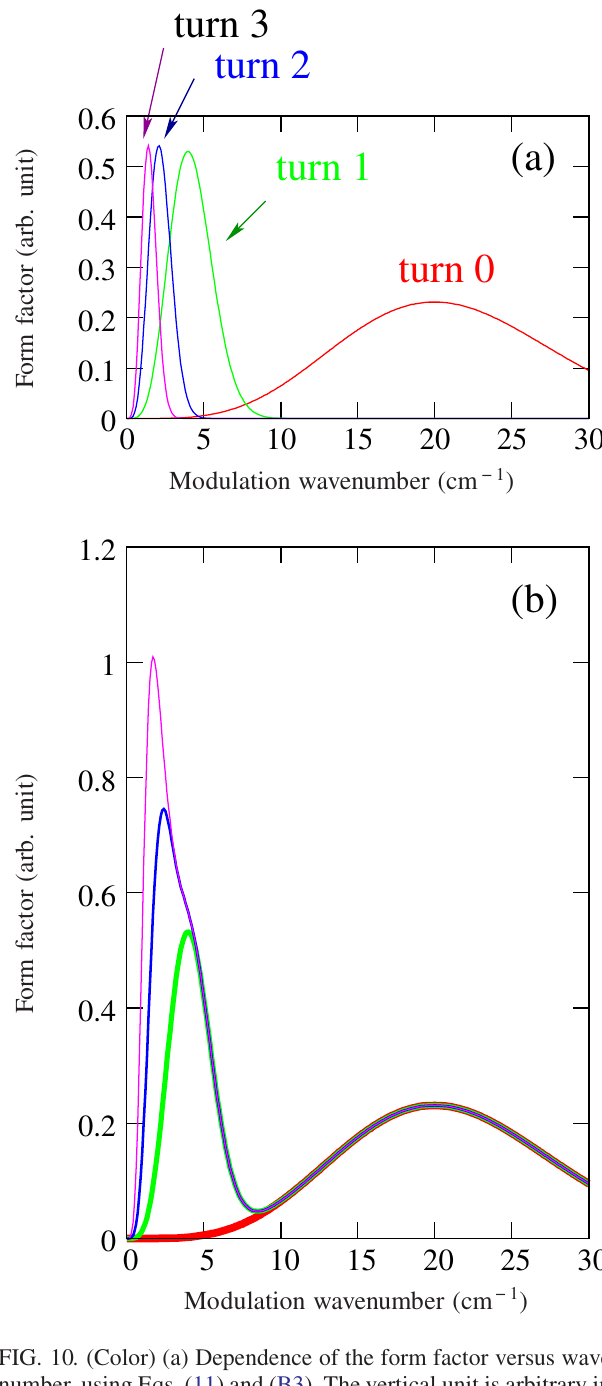
FIG. 10. (Color) (a) Dependence of the form factor versus wave number, using Eqs. (11) and (B3). The vertical unit is arbitrary in the sense that we took P ¼ C ¼ 1 in the calculation. ‘‘turn 0’’ associated with a straight corresponds to the parameters R ij transport from the undulator to the bending magnet. Labels ‘‘turn 0’’, ‘‘turn 1’’, ‘‘turn 2’’, ‘‘turn 3’’, correspond to R ij parameters associated to a straight transport, 1 full turn, 2 full turns, 3 full turns in the storage ring, respectively. Part (b) represents the sum of the first form factors: turn 0 only (red), sum of turns 0 and 1 (green), sum of turns 0, 1, and 2 (blue), sum of turns 0, 1, 2, and 3